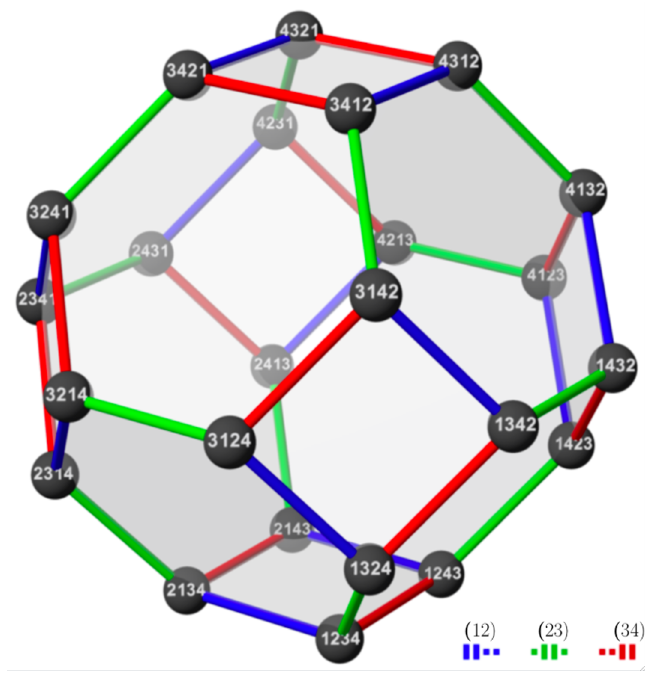
Figure 7 . S 4 permutation elements and the truncated